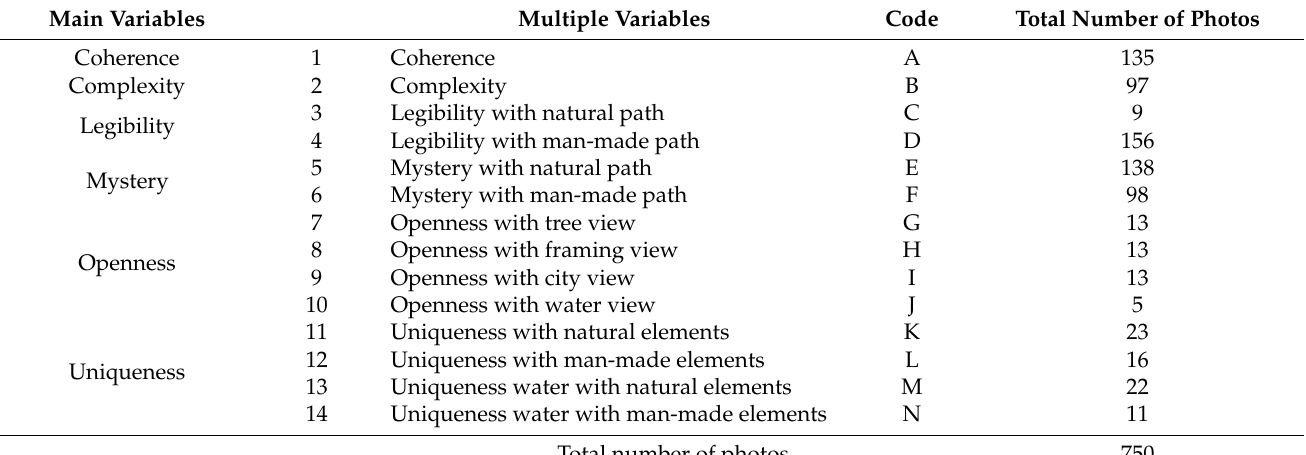
Table 5. Identification of multiple visual aesthetic variables for permanent urban forest